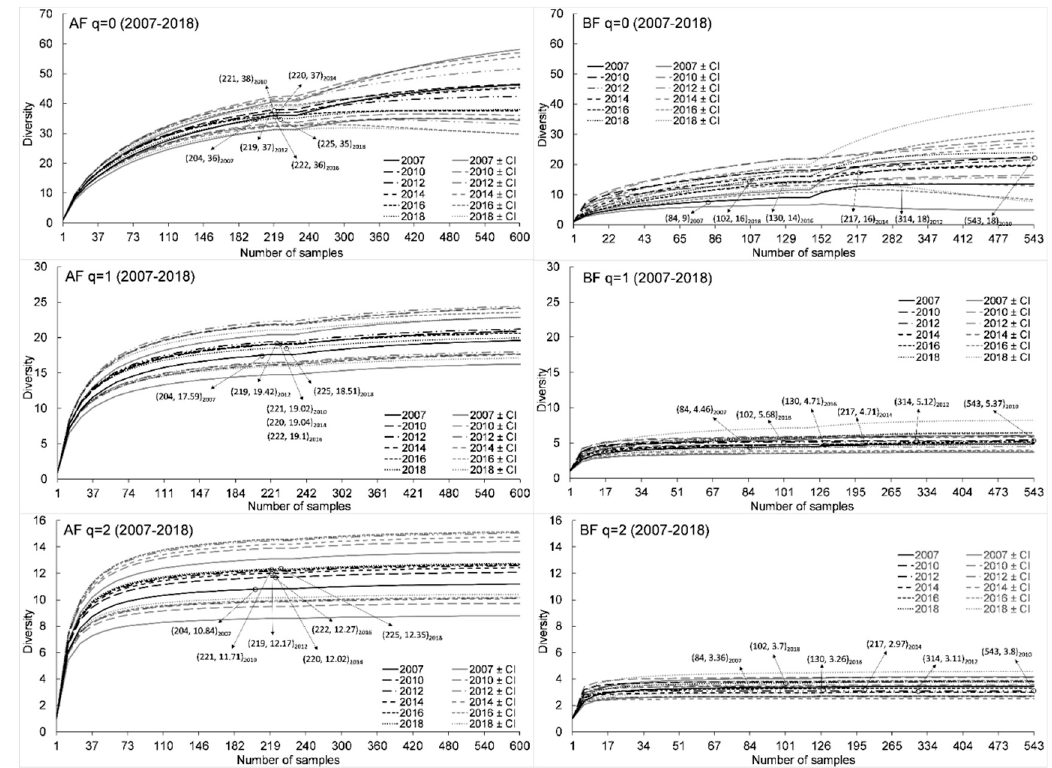
Figure A1. Yearly sample-based rarefaction curves and respective confidence intervals (CI) for AF and BF for Hill numbers ( q = 0 to 2). Circles depict incidence data that have been recorded; data to the right of circles are extrapolated.